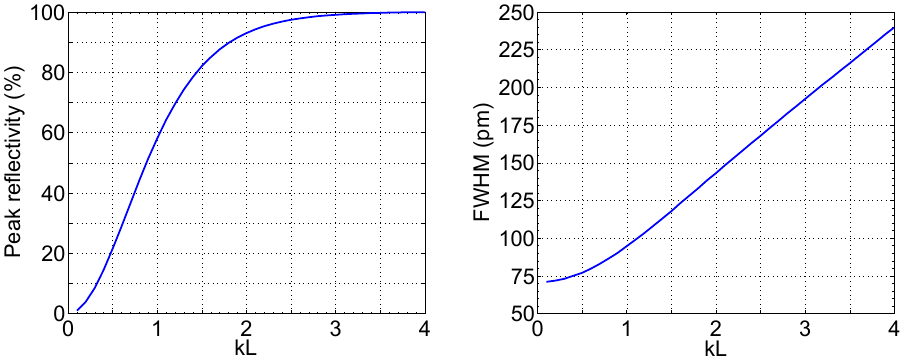
Figure 1. Peak reflectivity ( left ) and FWHM ( right ) for a uniform FBG as a function of the grating strength coefficient kL . Parameters: L = 1 cm, n eff = 1.5, δ n eff = 10 − 6 , λ B = 1550 nm.